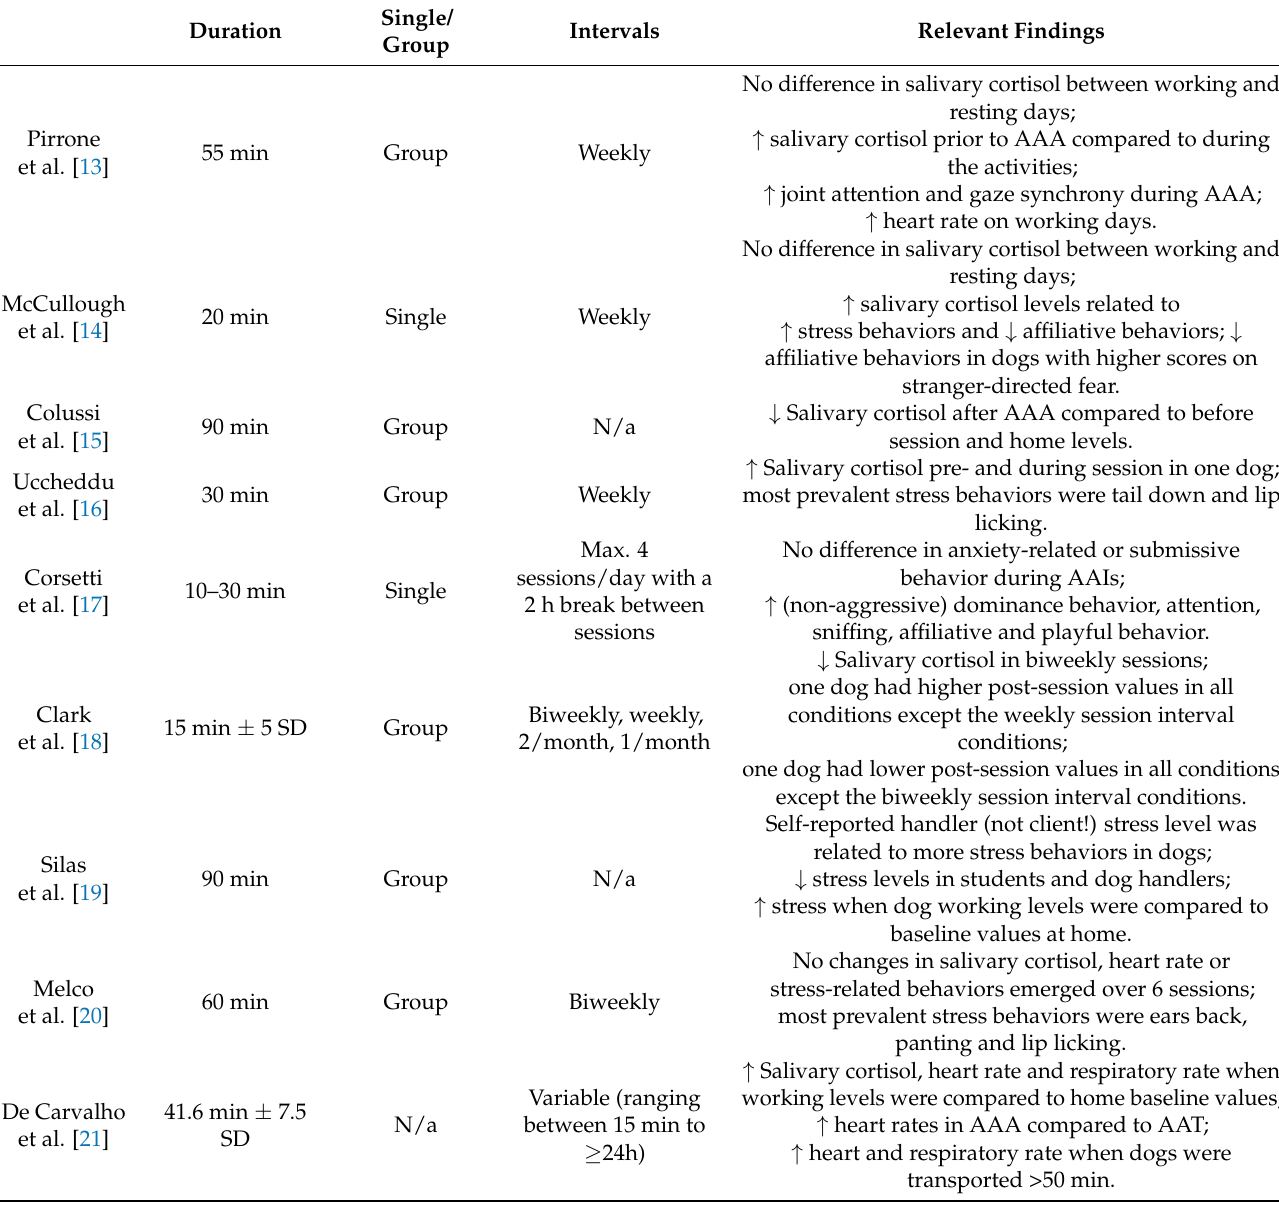
Table 2. AAI session characteristics including duration, organization of recipients (single or group sessions), between session intervals and significant